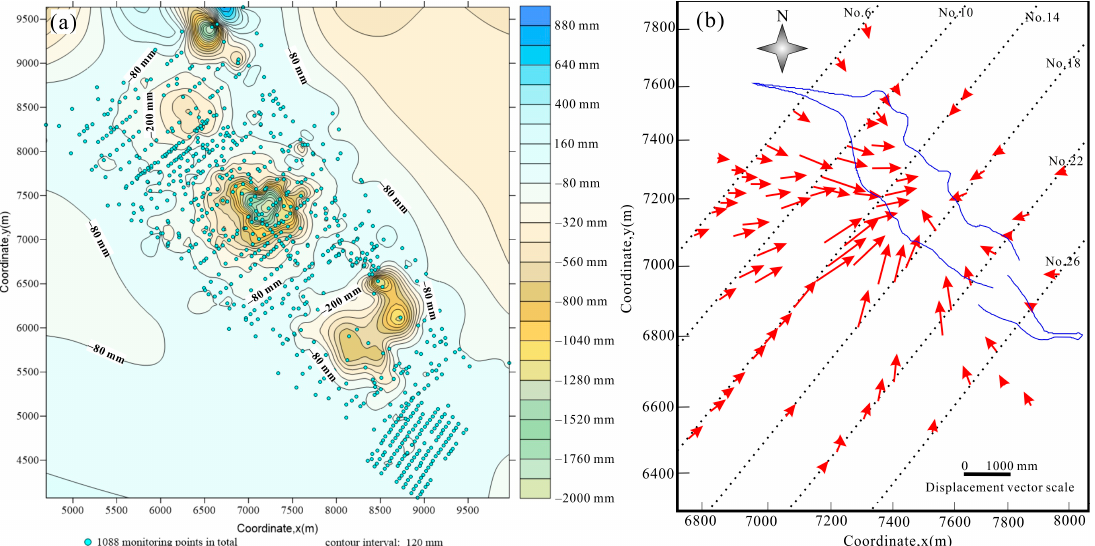
Figure 2. Characteristics of vertical and horizontal displacement at the Jinchuan Nickel Mine: ( a ) Distribution of GPS monitoring points at Jinchuan Nickel Mine overlying a contour map of the vertical displacements recorded for October 2015, using May 2005 as a baseline. ( b ) Diagram of horizontal displacement vectors at mine field No.2 in October 2015, using May 2001 as a reference measure.